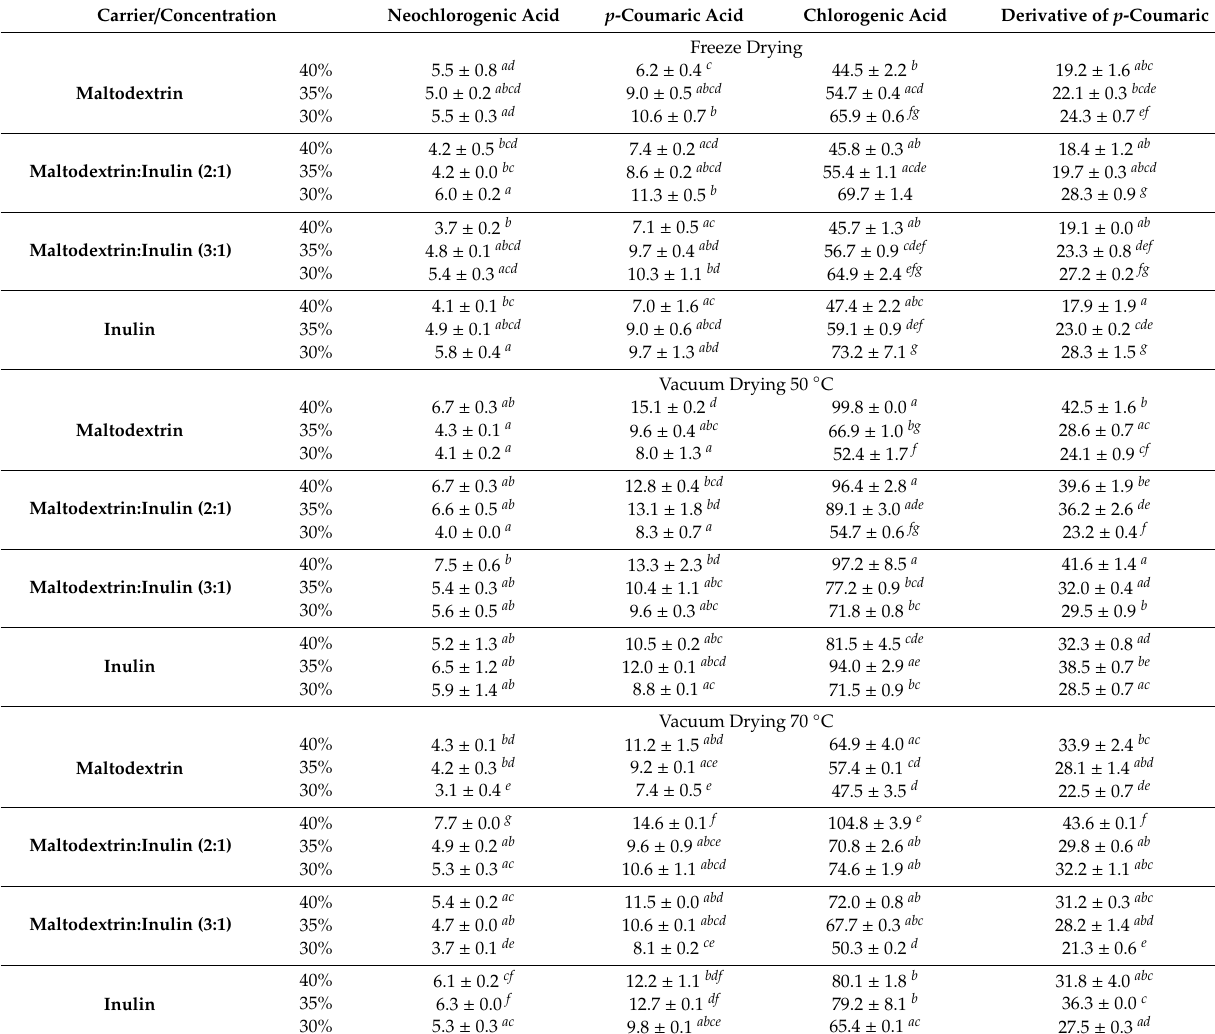
Table 3. The content of phenolic acids (mg / kg db) identified in blackcurrant juice powders made with the addition maltodextrin, inulin, and a mixture of maltodextrin–inulin using di ff erent drying methods (average ± SD; n =